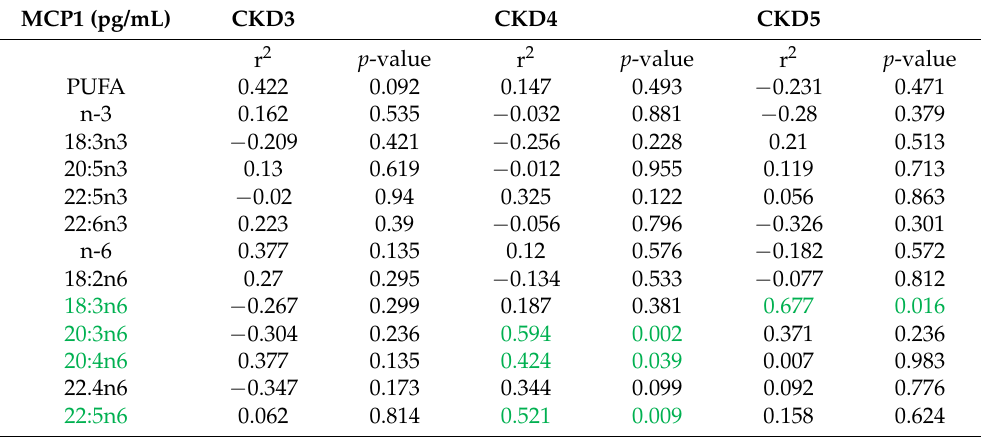
Table 3. Correlation between PUFA and MCP1 among CKD stages. p < 0.05, “ − ” indicates a negative correlation. Two-tailed Spearman bivariate analysis. MCP1 (pg/mL) CKD3 CKD4